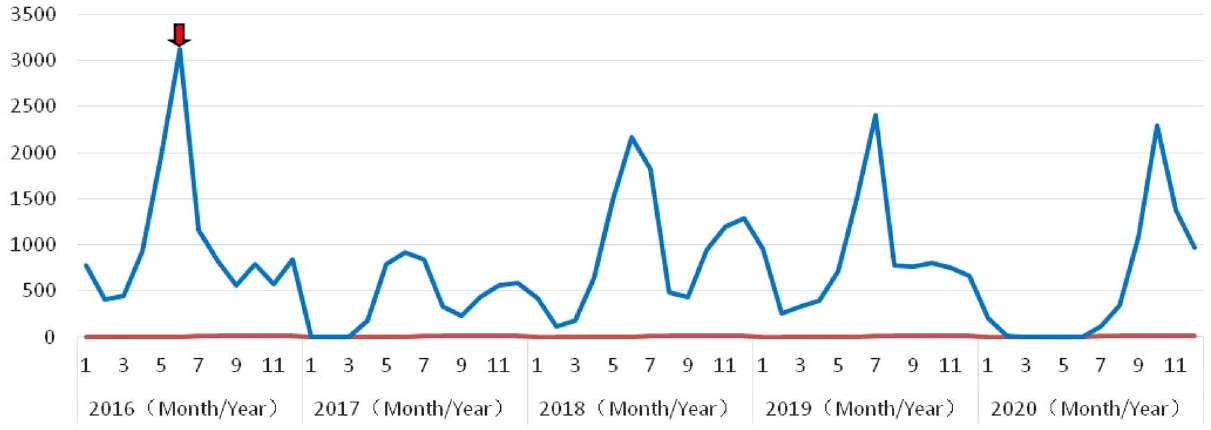
Figure 2. The temporal distribution with periodic peak of HFMD in Kunming, 2016–2020. The red arrow indicates that the local CDC began to vaccinate local children with EV-A71 vaccine in June